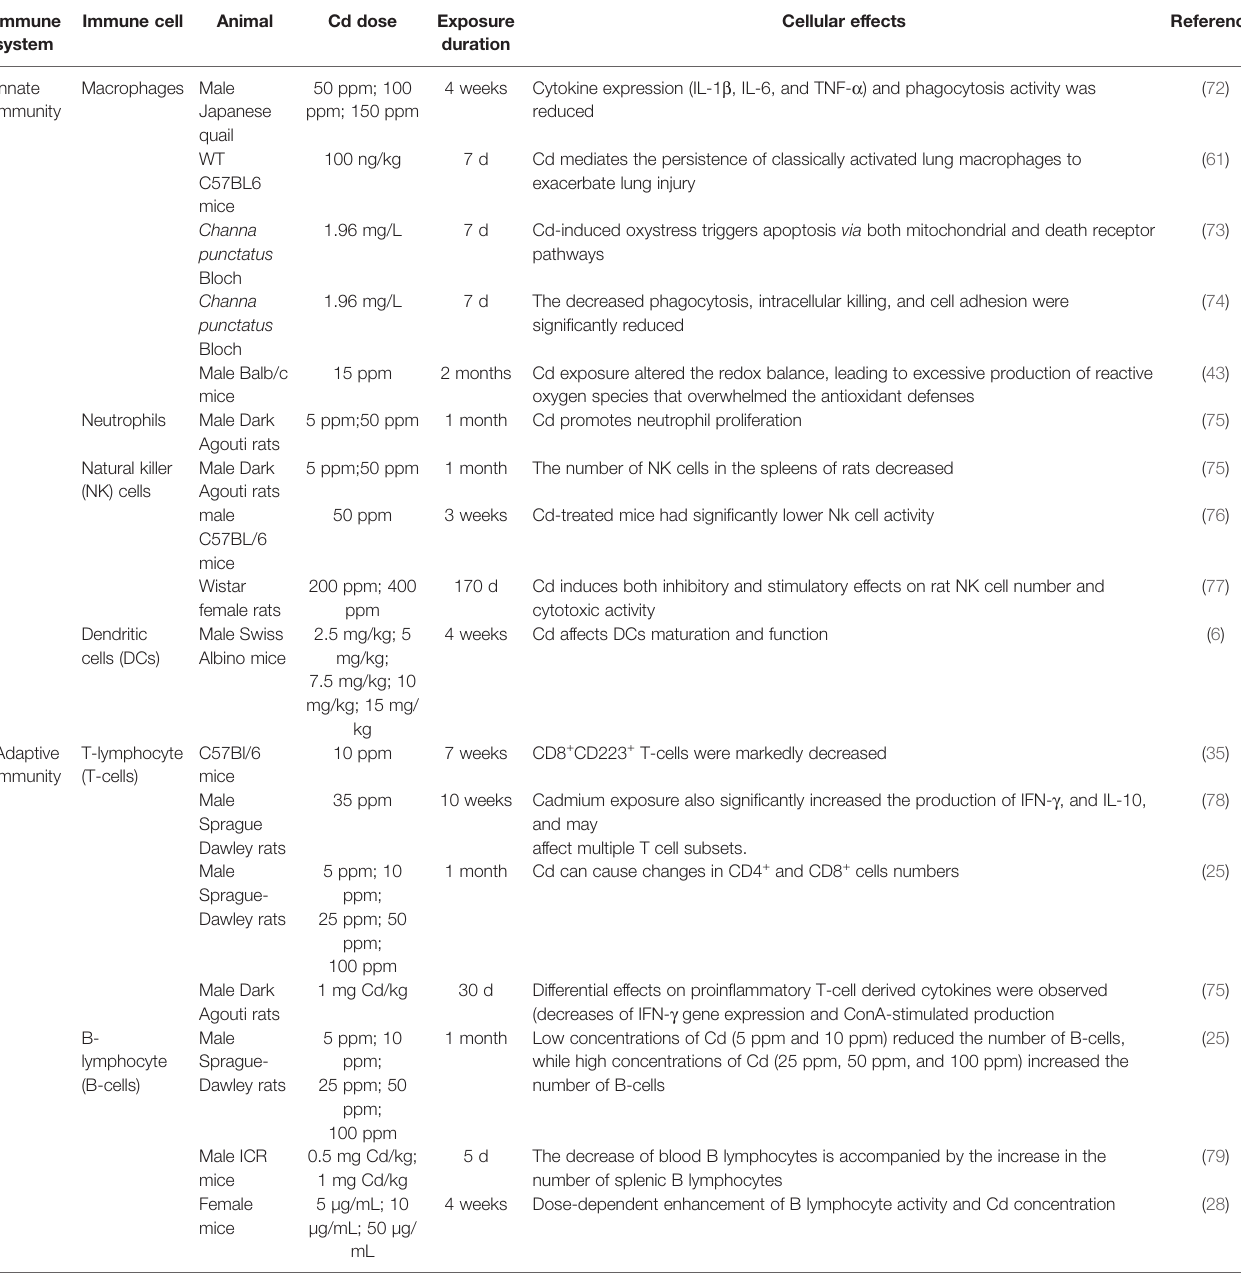
TABLE 2 | Effects of cadmium exposure on immune cells under experimental conditions in vivo